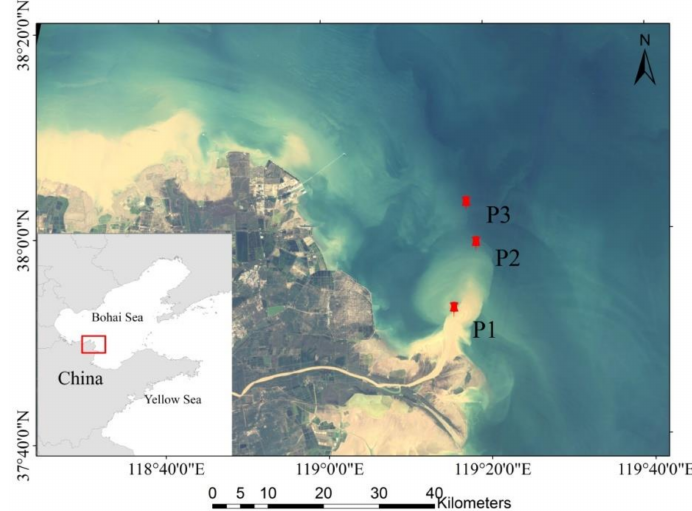
Figure 1. Location of in-situ stations in the Yellow River Estuary. Three continuous observations were conducted on 4 December 2011 (P1), 25 November 2011 (P2), and 11 December 2011